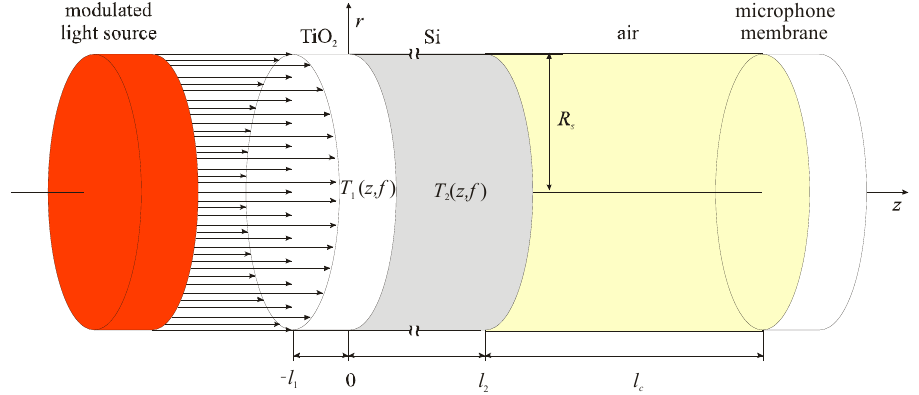
Figure 3. The simplest scheme of the two − layer sample irradiated by modulated light source. l 1 and l 2 ( l 1 << l 2 ) are the thicknesses of the thin − film (TiO 2 ) and substrate (Si), respectively. R s is the sample radius, T 1 ( z , f ) and T 2 ( z , f ) is the temperature distribution in the thin-film and substrate. The total photoacoustic sound signals δ p total ( f ) , (Equation (5)) are usually represented using its amplitudes A ( f ) and phases φ ( f ). Therefore, δ p total ( f ) , can be written as a complex